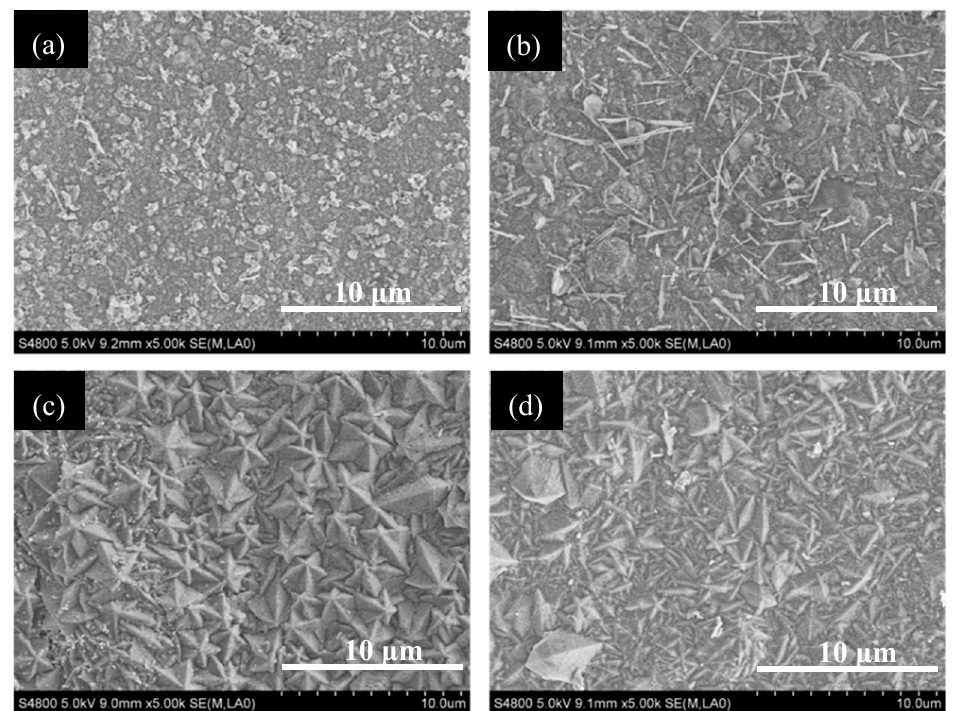
Figure 6. SEM images of carbon deposits on the surface of TiN coatings with different micromorphology after the coking test: ( a ) disordered sheet structure (corresponding to Figure 4(B2)), ( b ) rounded agglomerate structure (corresponding to Figure 4(A2)), ( c ) big star-shaped crystals (corresponding to Figure 4(C2)), and ( d ) lenticular crystals (corresponding to Figure 4(C1)).